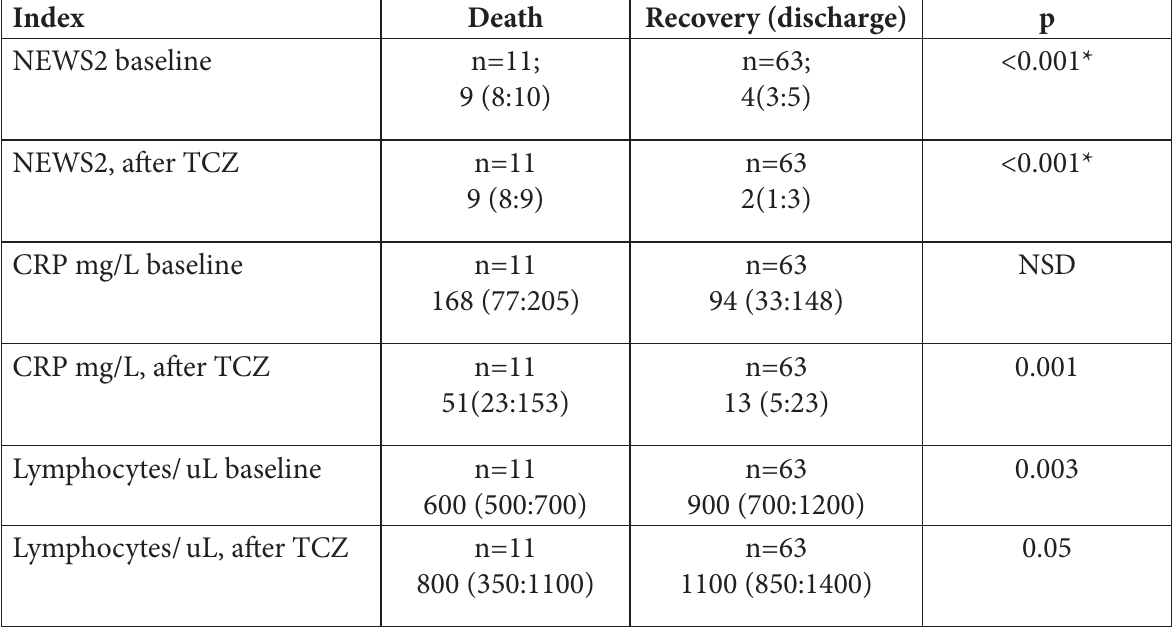
Table 3. Comparison of clinical and laboratory indices in patients who recovered or died